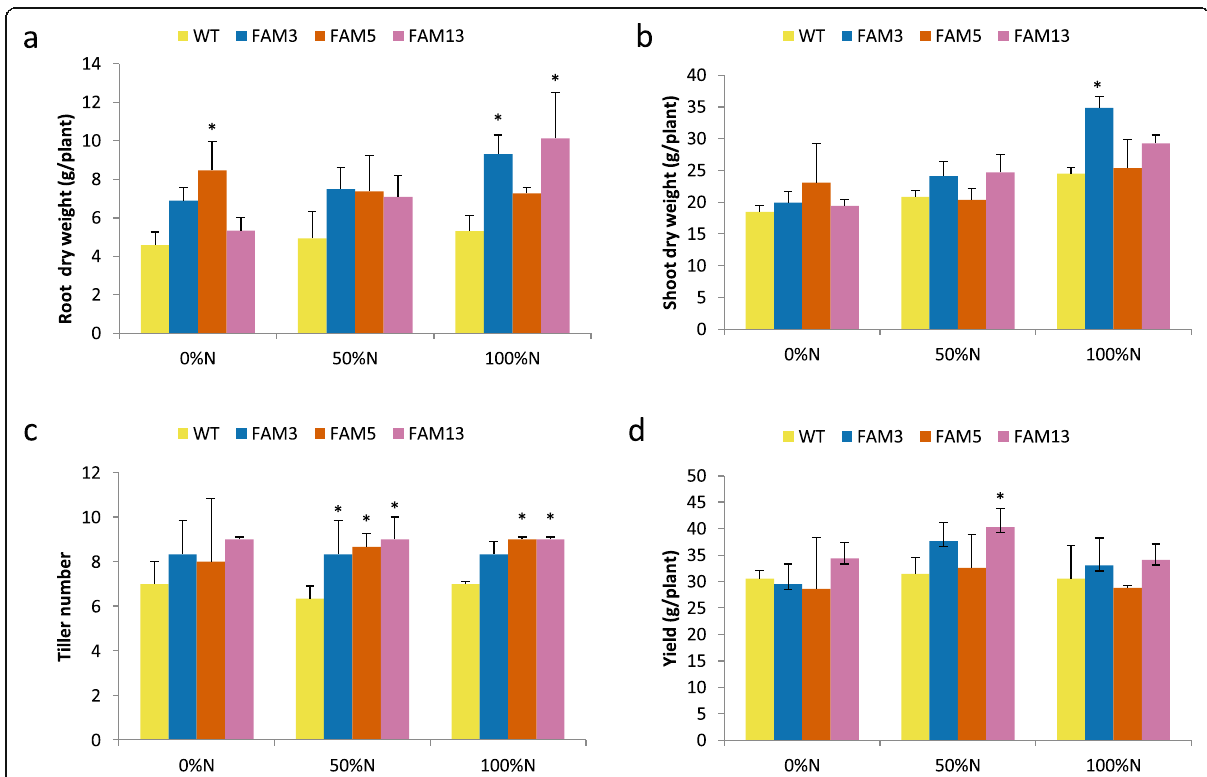
Fig. 2 Greenhouse experiment for evaluation of nitrogen use efficiency in transgenic events and wild type. a Root dry weight of three transgenic events and wild type at 3 N doses. b Shoot dry weight of three transgenic events and wild type at 3 N doses. c Tiller number of three transgenic events and wild type at 3 N doses. d Grain yield of three transgenic events and wild type at 3 N doses. Bars represent the means ± s.d. of three replicates. Means labeled with * indicate significant differences from WT at the corresponding N dose at P < 0.05